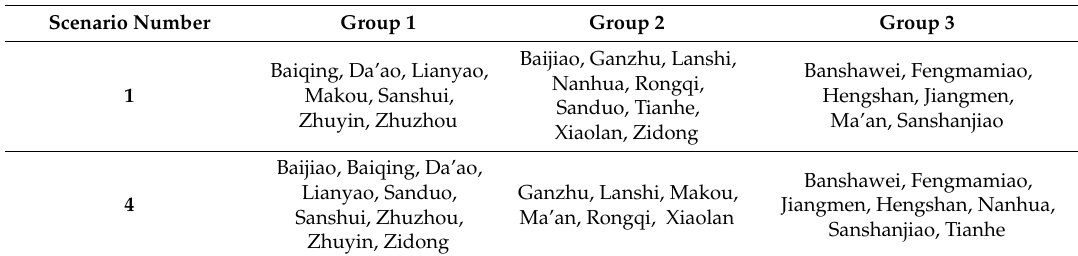
Table 5. K-means clustering results.